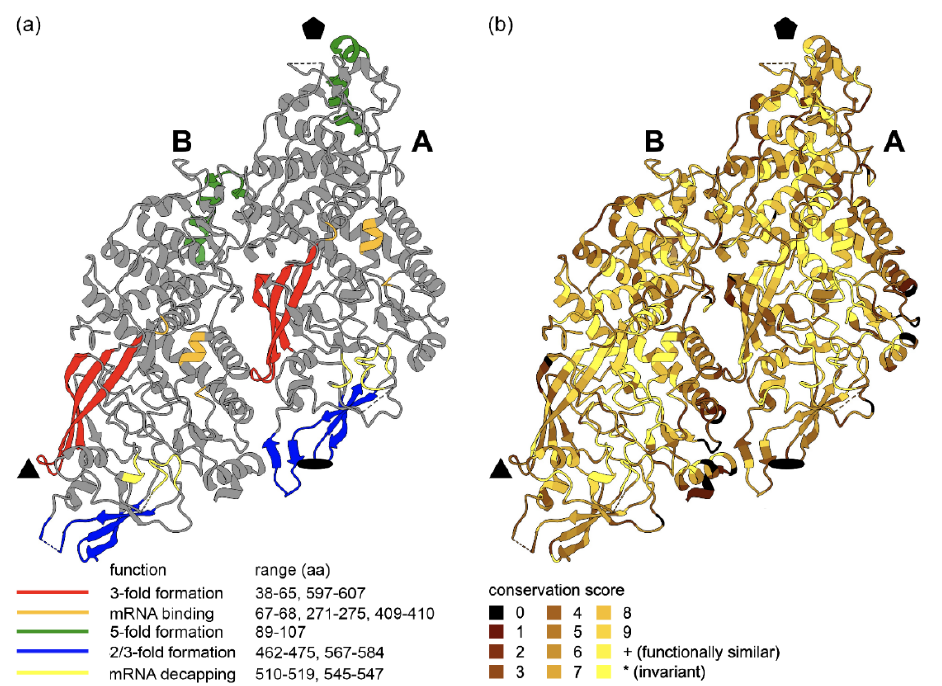
Figure 5. Three-dimensional structure of LRV1 capsid protein showing functional motifs and conservation. The asymmetric capsid unit, formed by subunits A and B, representing folding variants of the same protein, is shown. The approximate positions of five-fold, three-fold and two-fold symmetry axes around the unit are marked by black pentagon, triangle and ellipse, respectively. ( a ) Position of functional regions (residue numbering is for LRV1-LgyM4147). ( b ) Conservation of amino acid residues in the alignment (Figure S3). Conservation scores are calculated in Jalview.